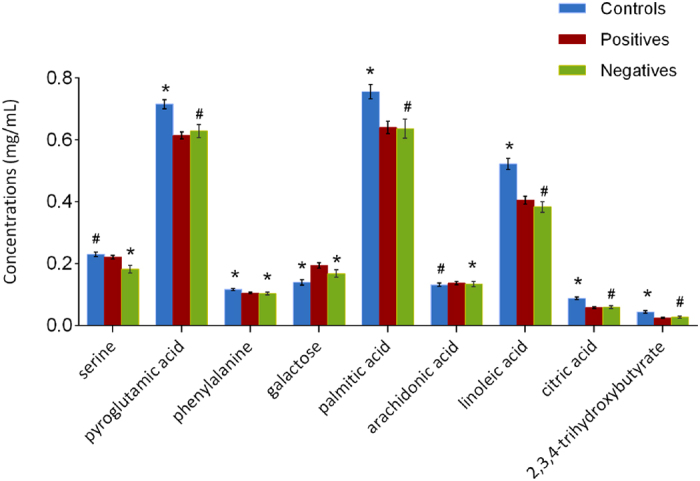
Comparison of the concentrations of nine potential metabolic biomarkers among control, negative and positive groups.Compared with the positive group, * denotes that the difference is considered statistically significant (p < 0.05), and # denotes that the difference is considered no statistically significant (p > 0.05).